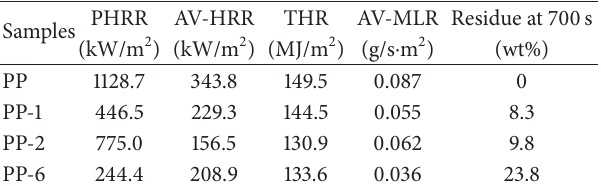
Table 3: Characteristic parameters of the cone calorimetric test for PP and flame retardant PP.